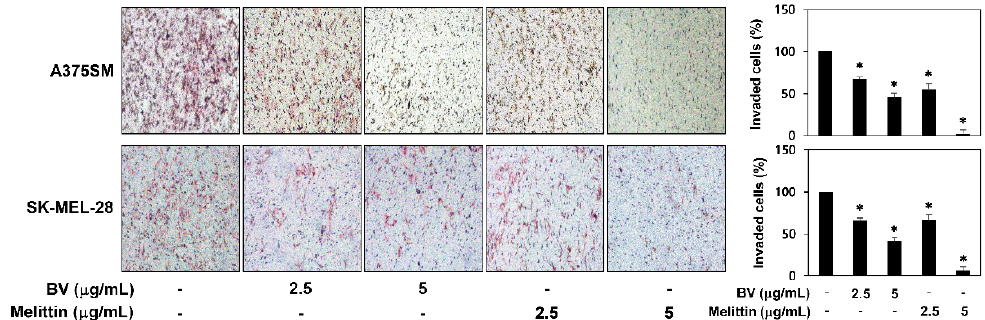
Figure 4. The effect of BV and melittin on the invasion of melanoma cell lines. The invasiveness of melanoma cells was analyzed using Matrigel-coated polycarbonate filters. Cells were treated with BV and melittin for 24 h. Cells penetrating the filters were stained and counted under an optical microscope. * p < 0.05 versus the control. Each value represents the mean ± SE from three independent experiments.